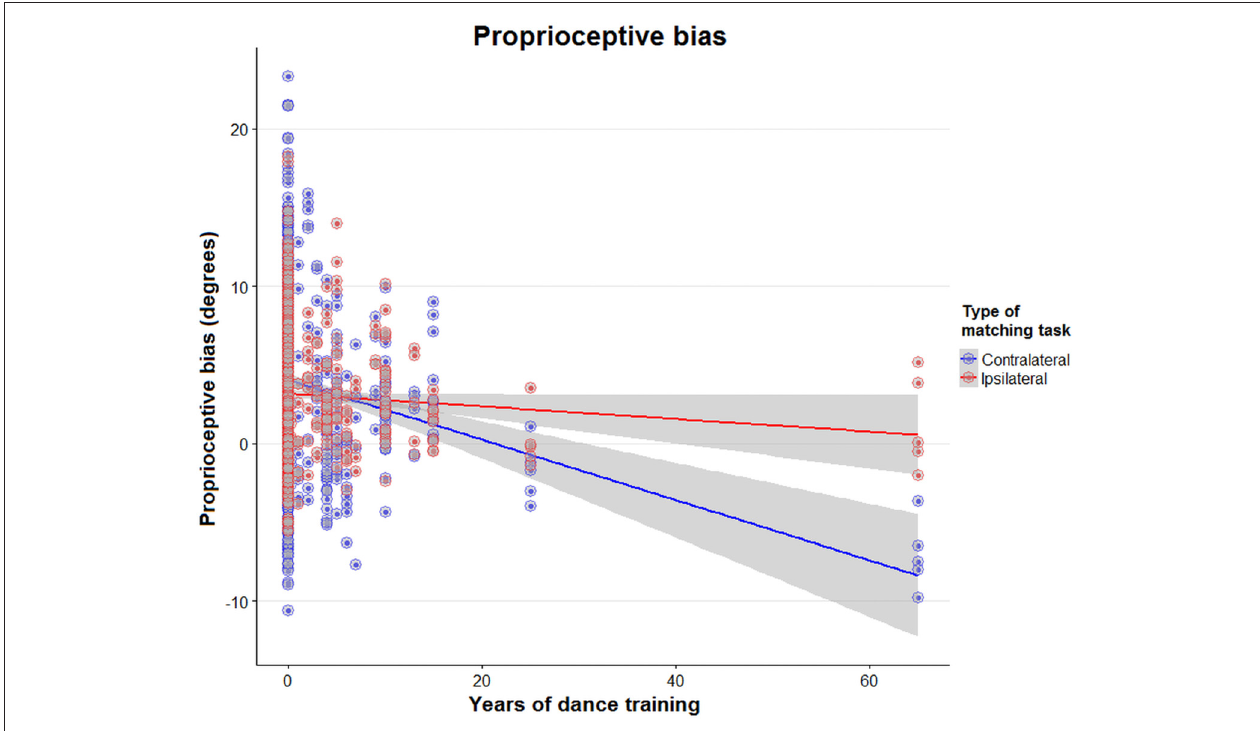
FIGURE 6 | Effect of years of dance training on ipsilateral and contralateral bias. Scatter plot of proprioceptive bias during a contralateral (blue) or ipsilateral (red) matching task in young and old adults, with data plotted against years of dance training. The regression lines show the association between years of dancing and proprioceptive bias in both matching